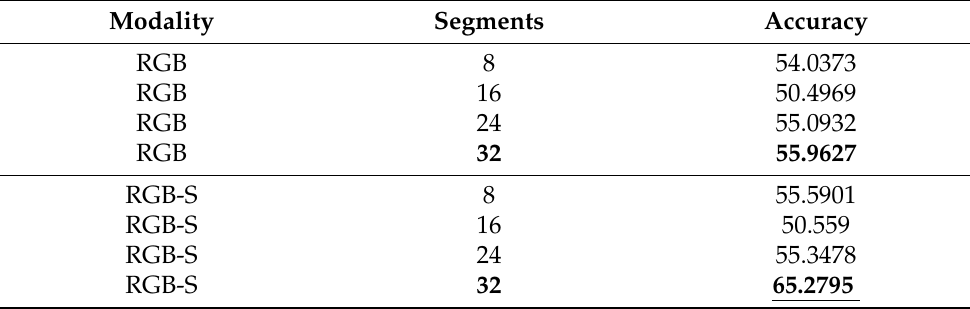
Table 2. Temporal Shift Module (TSM) results with different number of segments using RGB and RGB-S modalities.